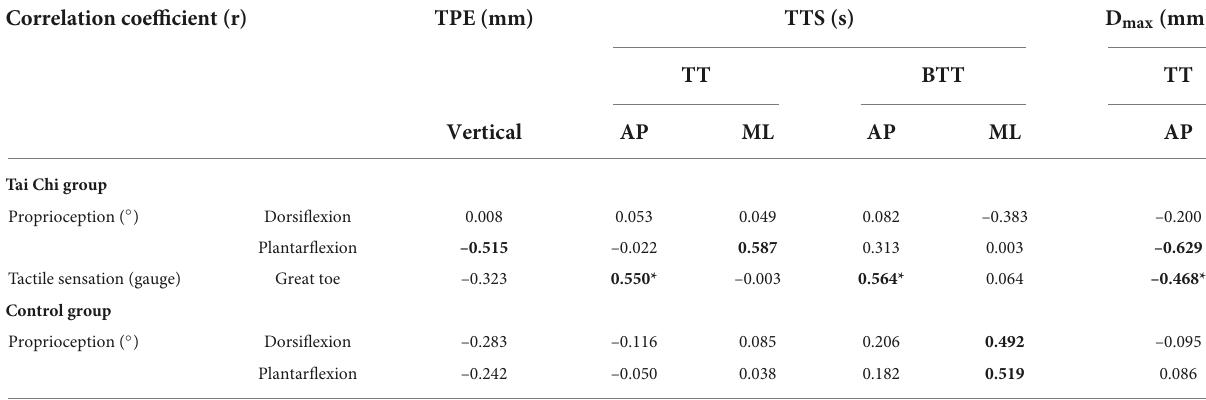
TABLE 4 Relationship of TPE, TTS, D max to proprioception and tactile